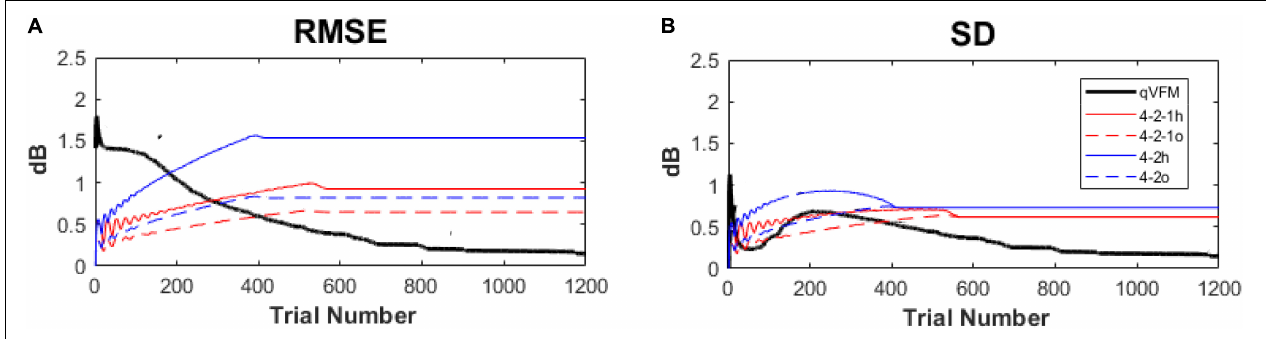
FIGURE 15 | Performance comparison between the qVFM method and staircase procedures in simulation tests across 1,000 runs. (A) Average root mean squared error, (B) Average standard deviation. Results from the qVFM are shown in black solid lines. Results from the staircase 4-2-1 algorithm of h and o methods are shown in red solid and dashed lines. Results from the staircase 4-2 algorithm of h and o methods are shown in blue solid and dashed lines. The h method uses the last seen stimulus intensity as the estimated threshold, the o method uses the average of the last seen and unseen stimulus intensities as the estimated threshold.